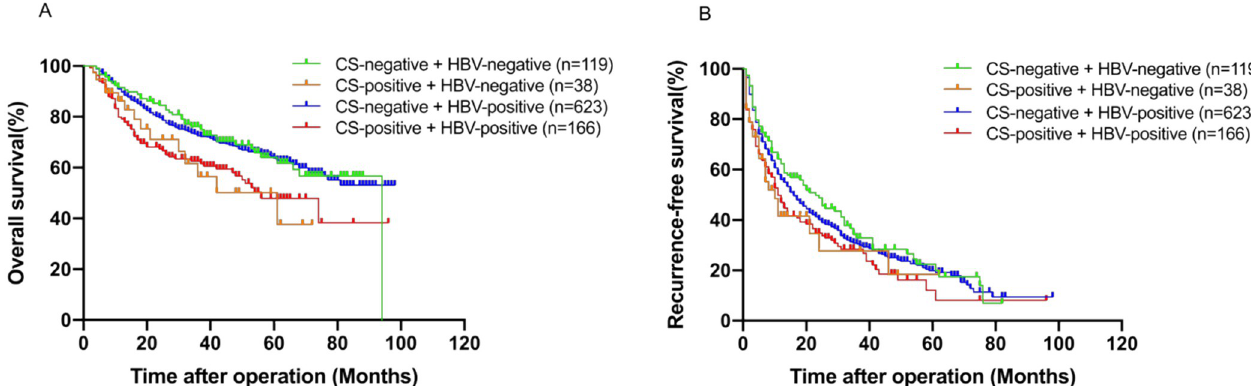
Fig 3. Comparison of OS and RFS among patients of groups 1 to 4. (A) The OS rates (P1–2 = 0.052, P2–3 = 0.05, P1–3 = 0.863, P3–4 < 0.001, P1–4 = 0.012, P2–4 = 0.924); (B) the RFS rates (P1–2 = 0.098, P2–3 = 0.206, P1–3 = 0.308, P3–4 = 0.028, P1–4 = 0.02, P2–4 = 0.976). Group 1 (n = 119), CS-negative + HBV- negative; group 2 (n = 38), CS-positive + HBV-negative; group 3 (n = 623), CS-negative + HBV-positive; group 4 (n = 166), CS-positive + HBV-positive. CS, Clonorchis sinensis; HBV, Hepatitis B virus; OS, overall survival; RFS, recurrence-free survival.